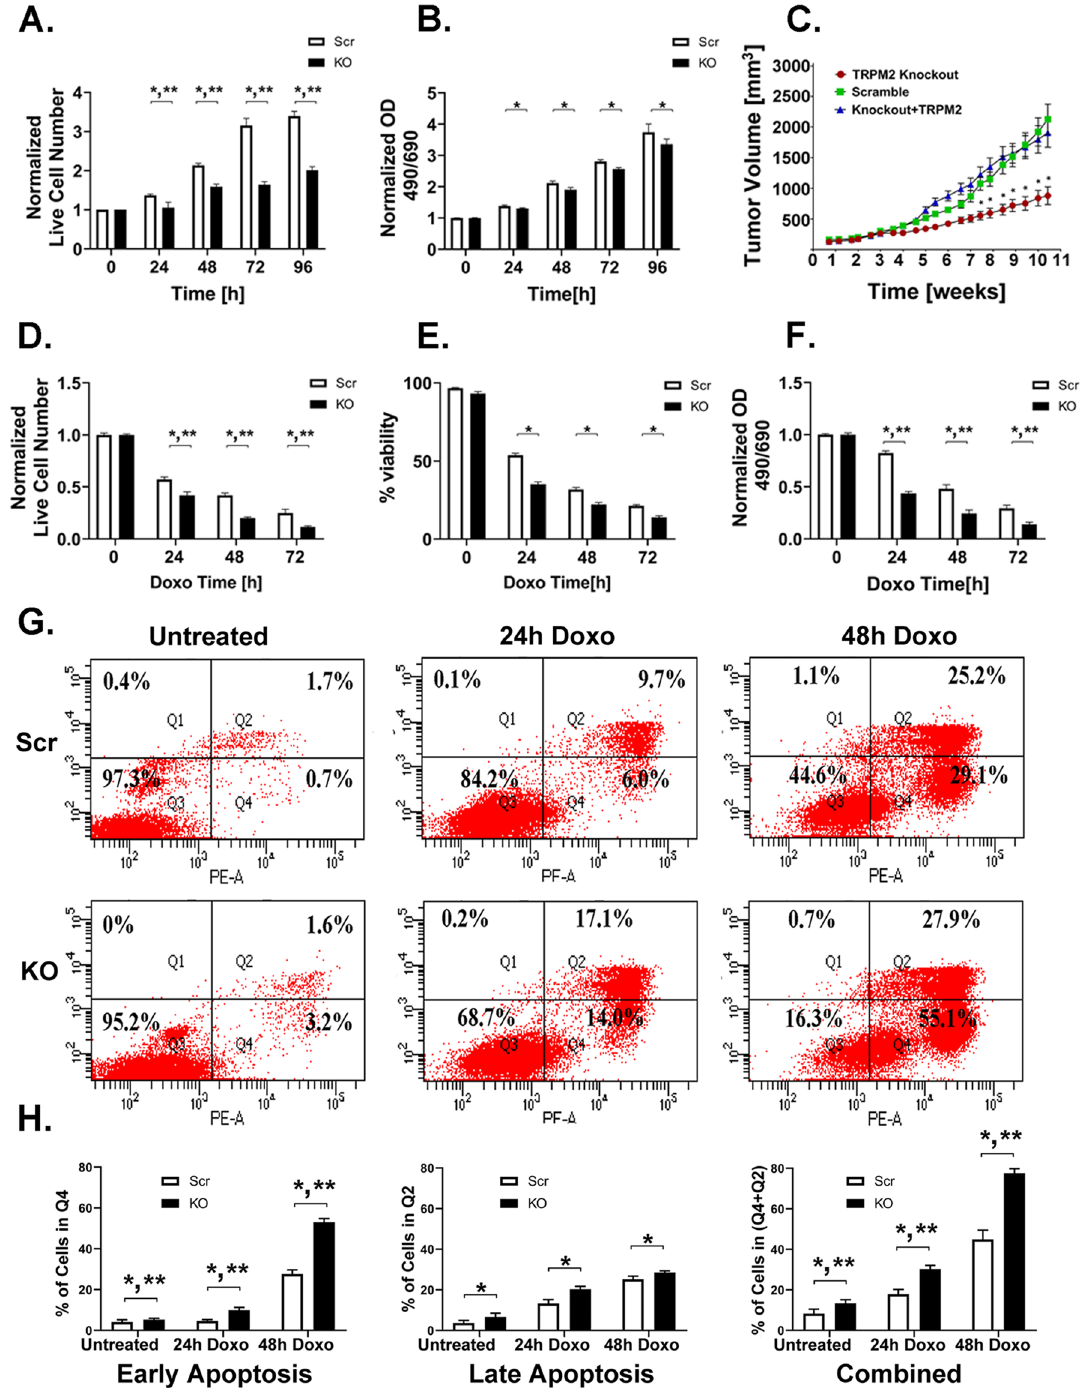
Figure 1. TRPM2 KO in neuroblastoma reduces proliferation, viability and increases apoptosis. Cell proliferation and viability were studied in SH-SY5Y cells in which TRPM2 was deleted with CRISPR technology (KO) and in scrambled control (Scr). ( A , B ) Cell proliferation was measured in two clones of TRPM2 deleted (KO) and in scrambled control (Scr) SH-SY5Y cells with trypan blue exclusion ( A ) and XTT analysis ( B ), 24 to 96 h after plating in two experiments. Mean ± S.E.M. is shown ( A , n = 16/group; B , n = 12/ group). ( C ) Xenograft tumor growth was measured in tumors from two clones of KO, scrambled, or KO cells reconstituted with wild type TRPM2. Mean ± S.E.M. for two clones combined (n = 21/group). ( D – F ) Cell viability was measured with trypan blue ( D , E ) and XTT analysis ( F ) 24 to 72 h after treatment with 0.3 µM doxorubicin in two experiments ( D , E , n = 16/group; F, n = 12/group). Results were normalized to time 0 and mean ± S.E.M. from two experiments is shown. ( G , H ) Apoptosis was measured in Scr and TRPM2 KO synchronized cells untreated or treated with doxorubicin (0.3 µM) for 24 or 48 h. ( G ) Cytometric analysis in a representative experiment is shown. ( H ) Mean ± S.E.M. percent of early apoptotic (Q4), late apoptotic (Q2) and all apoptotic (Q2 + Q4) cells in three experiments including the one shown in G (n = 5 replicates untreated cells; n = 8, 24 h; n = 6, 48 h). Statistics ( A – H ) two-way ANOVA, *p < 0.01, indicates significant differences between Scr vs KO, Group Effect; **p < 0.0001, group x time (indicates the differences between the groups significantly increased with time, A ) or group × doxorubicin exposure time interaction effect (indicates the differences between groups significantly increased with time of doxorubicin exposure, D , F , H